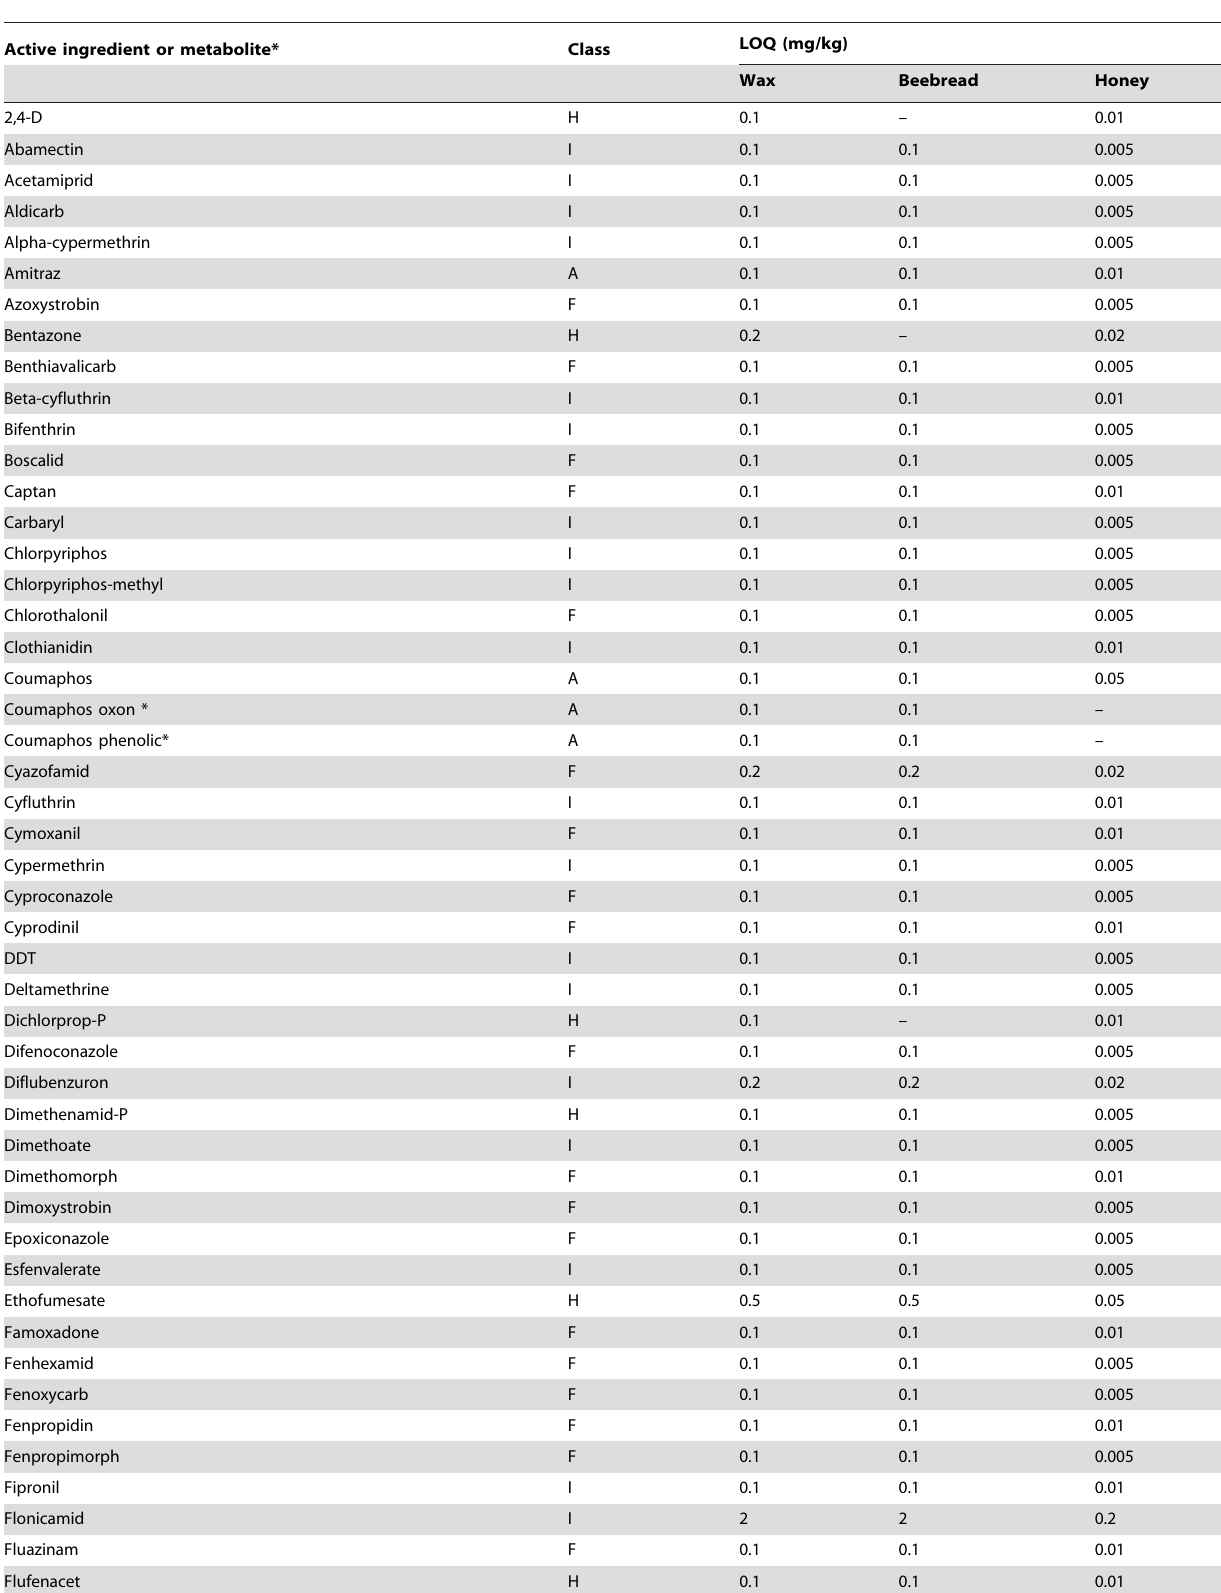
Table 2. Active ingredients or metabolite included in the multi-residue analyses by beekeeping matrix (A=Acaricide; F =Fungicide; H=Herbicide; I=Insecticide; S